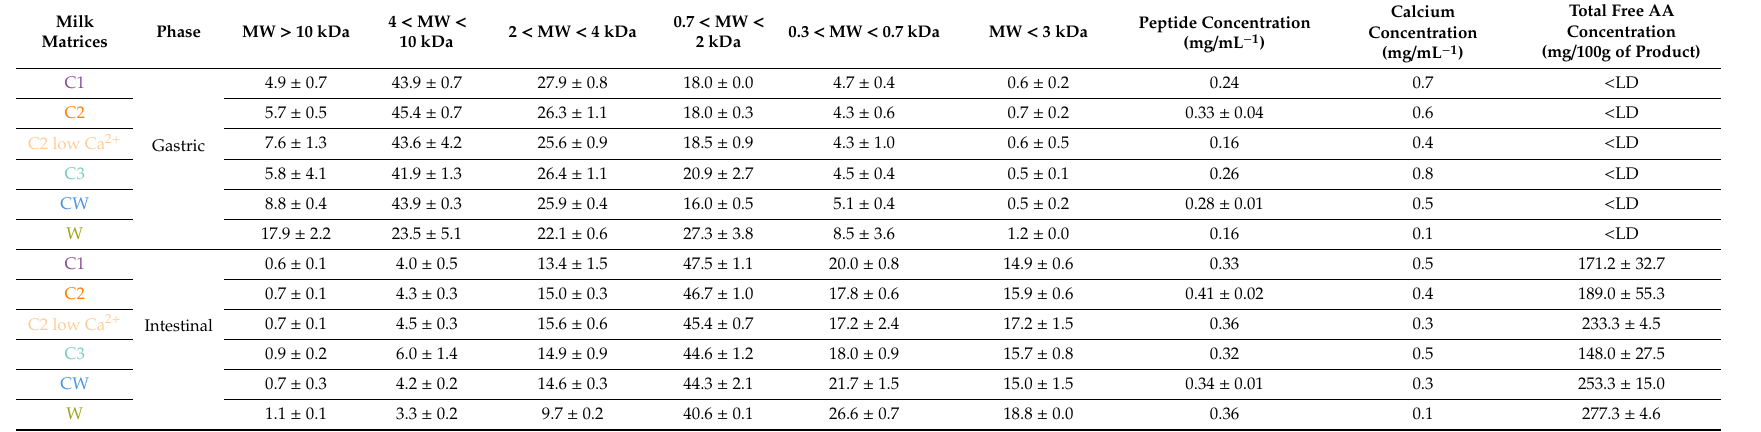
Table 2. Chemical data of the di ff erent matrices at the end of the gastric phase and at the end of the intestinal